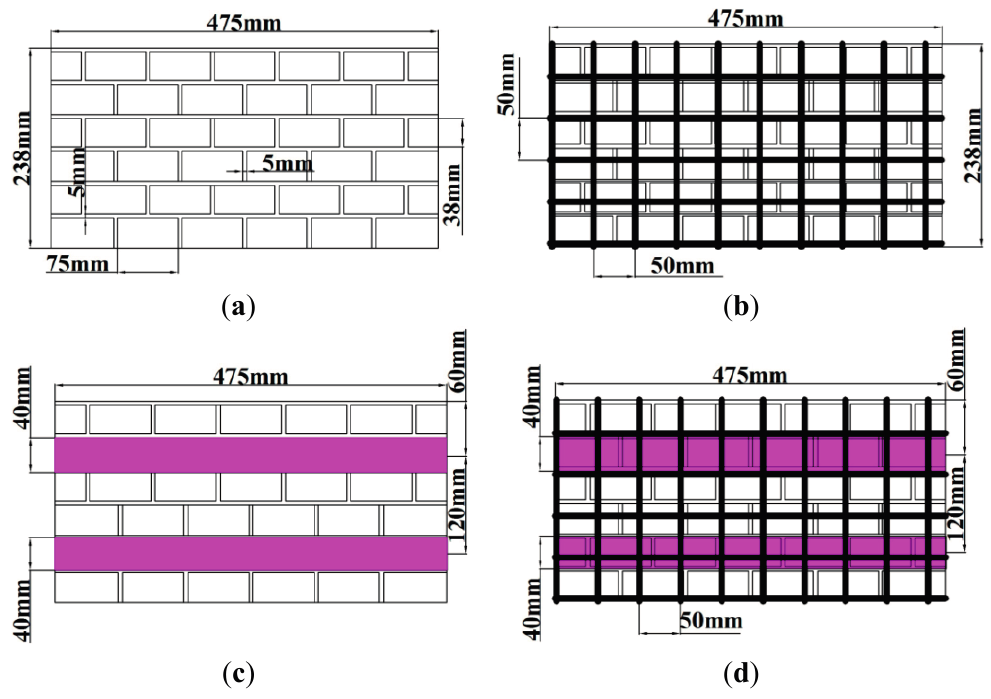
Figure 15. Panels retrofitting scheme for out-of-plane bending test: ( a ) non-retrofitted masonry panel, ( b ) PP-band retrofitted masonry panels, ( c ) FRP retrofitted masonry panel, and ( d ) FRP + PP-band retrofitted masonry